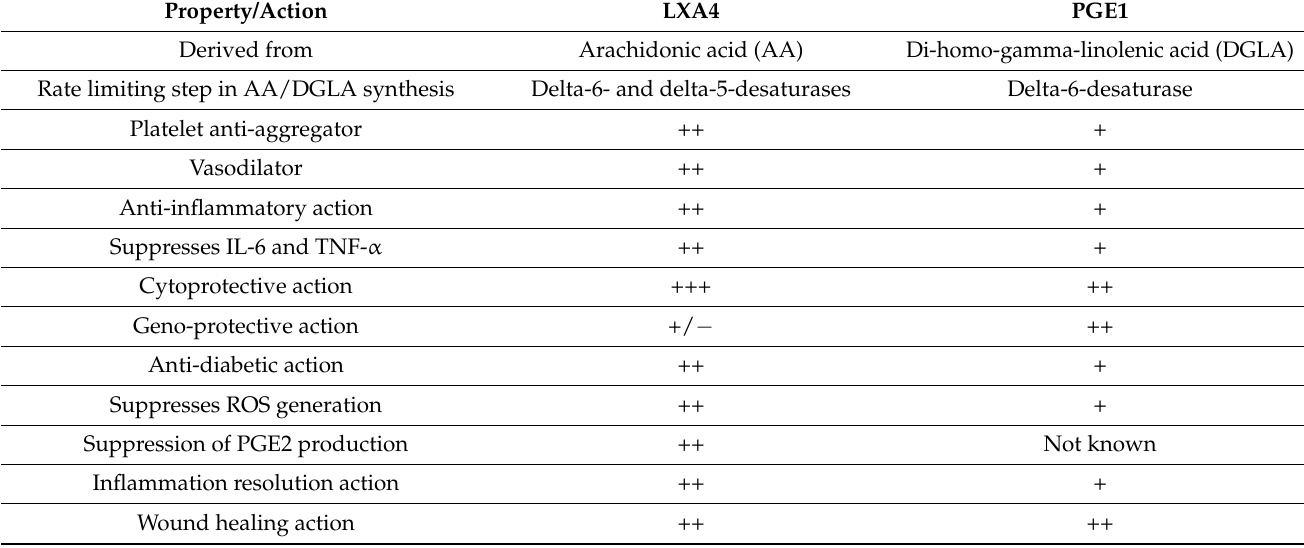
protectins and maresins from DHA. This data is taken from references [35,36]. Table 2. Comparison between PGE1 and